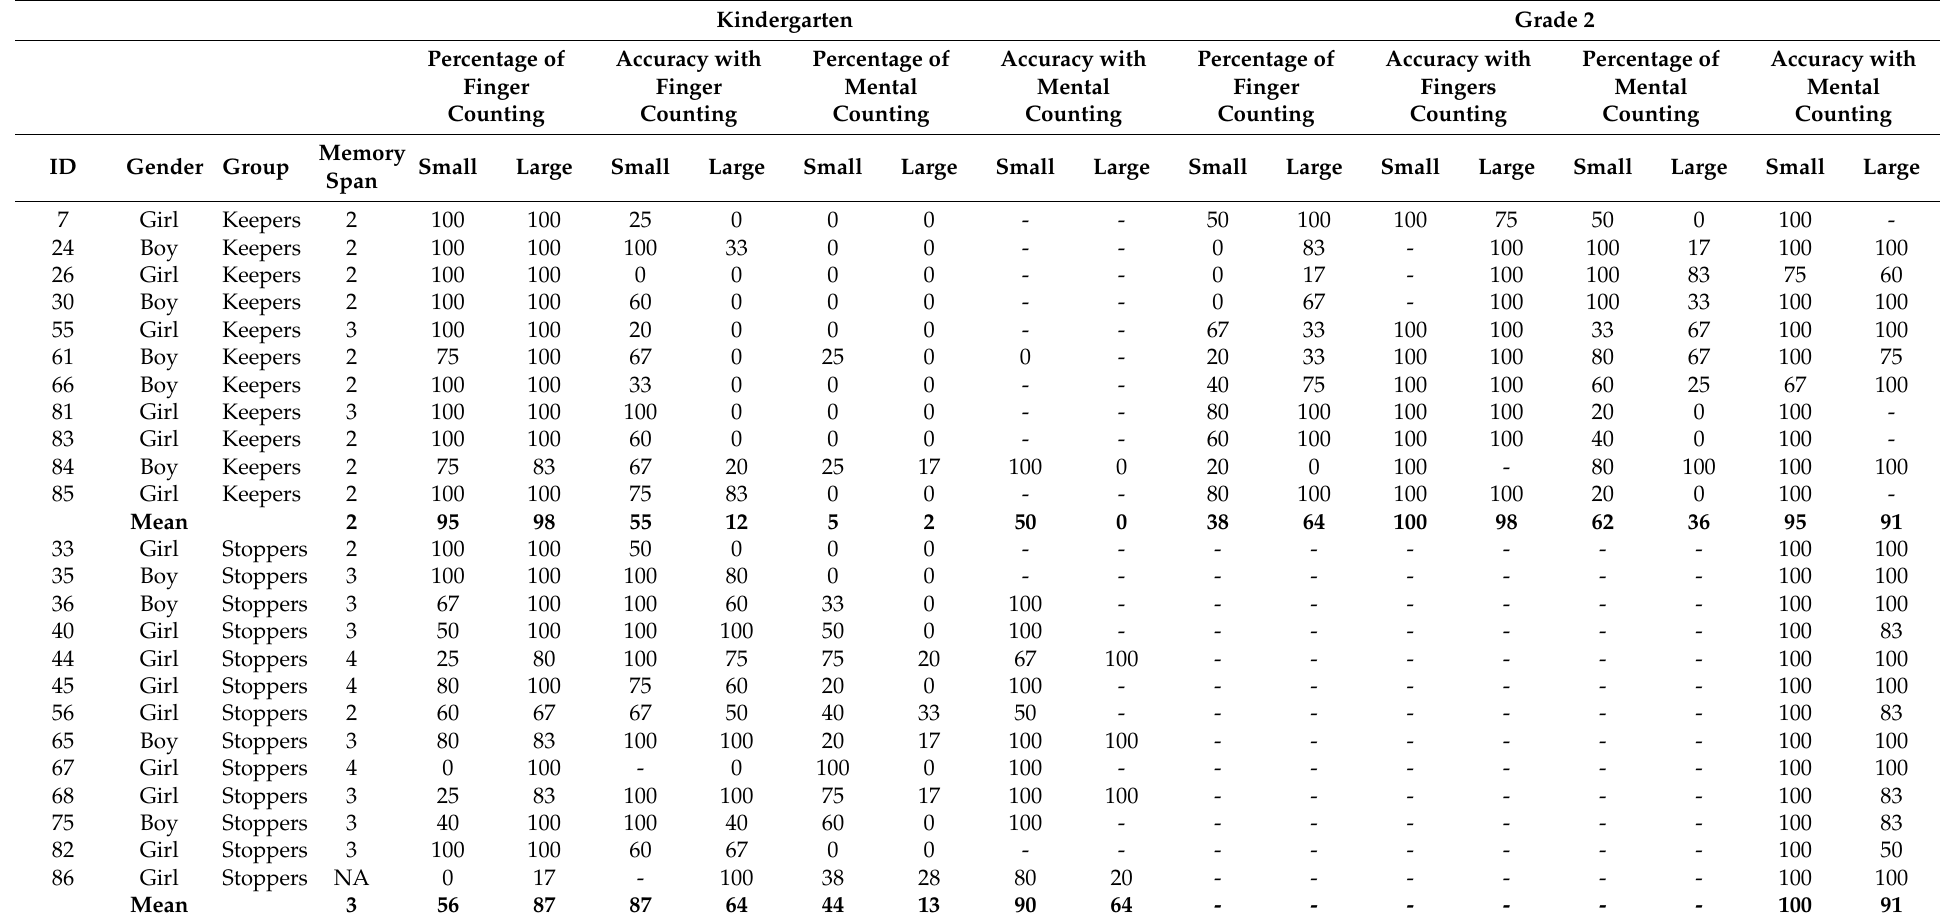
Table 1. Percentage of finger counting and mental strategies and accuracy in Kindergarten (left half of the Table) and in Grade 2 (right half of the Table) in keepers and stoppers. Means are reported in